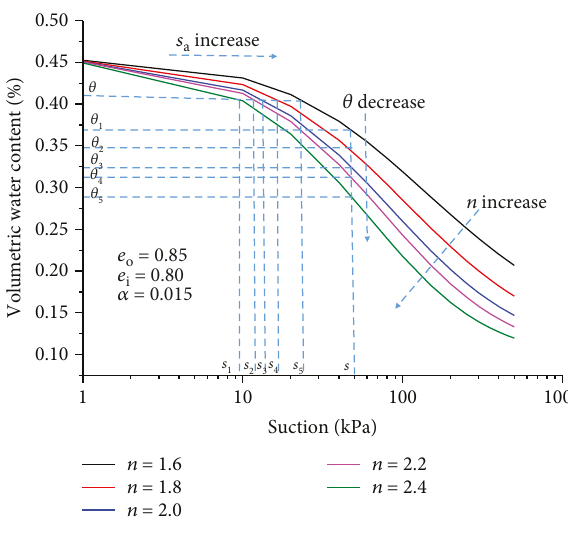
Figure 12: Result comparison at the void ratio of 0.6.